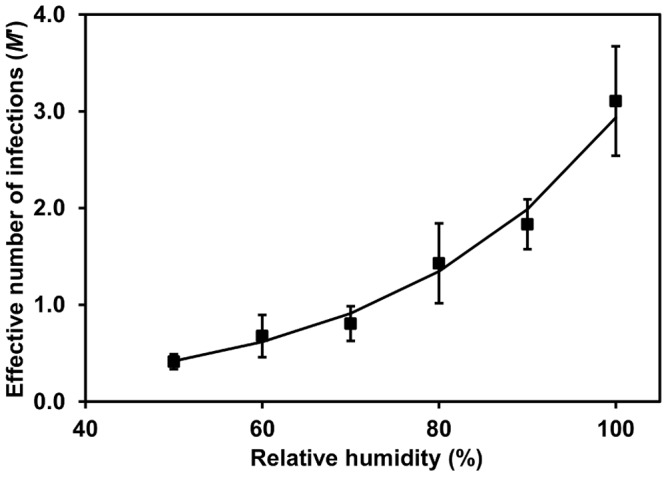
Effect of relative humidity (RH) on effective number of S. sclerotiorum infections.Points represent observed data, lines represent fitted functions. Error bars are the standard error of the mean (three replicates).